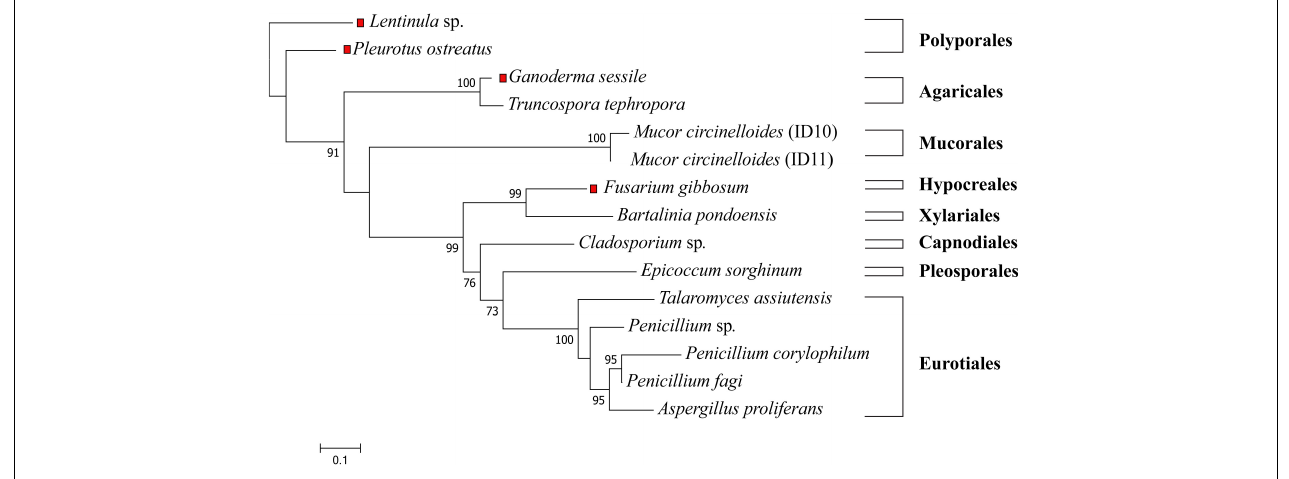
FIGURE 1 | Maximum likelihood tree of all tested fungi in this study. The ITS1-5.8S-ITS2 sequences were aligned with MAFFT, the phylogenetic tree was generated with FastTree using a GTR + G + I model and visualized with MEGA X. Bootstrap values are indicated on the nodes. The red squares represent terrestrial fungi that were not derived from E. radiata . The scale represents the sequence divergence between the number of nucleotide substitutions per